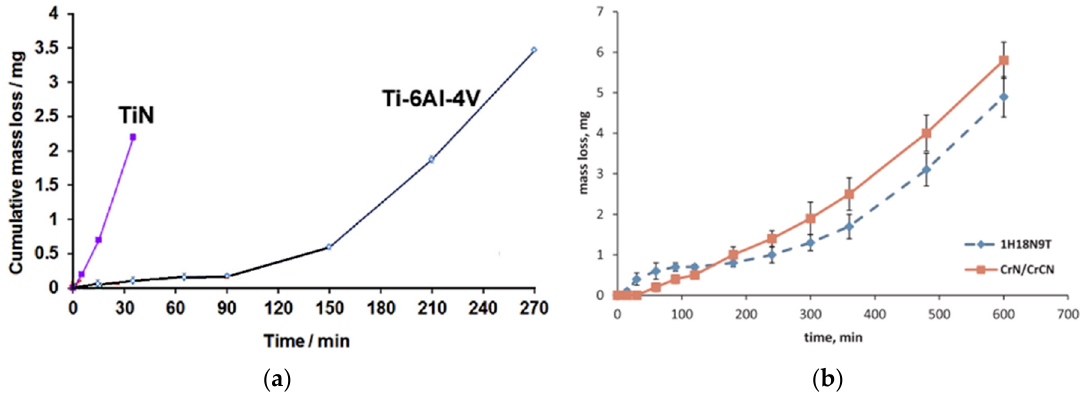
Figure 4. Cavitation curves of ( a ) 2.7 μ m thick TiN coating deposited on Ti6Al4V alloy by means of an unbalanced magnetron spattering method, reprinted from Journal of Alloys and Compounds , Reference [67], with permission from Elsevier and ( b ) 4.3 μ m thick CrN/CrCN coating deposited on austenitic steel by means of a cathodic arc evaporation method, reprinted from Wear , Reference [46], with permission from Elsevier.